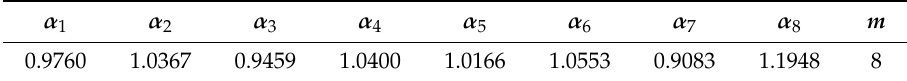
Table 5. Material parameters for YLD 2000-2D.